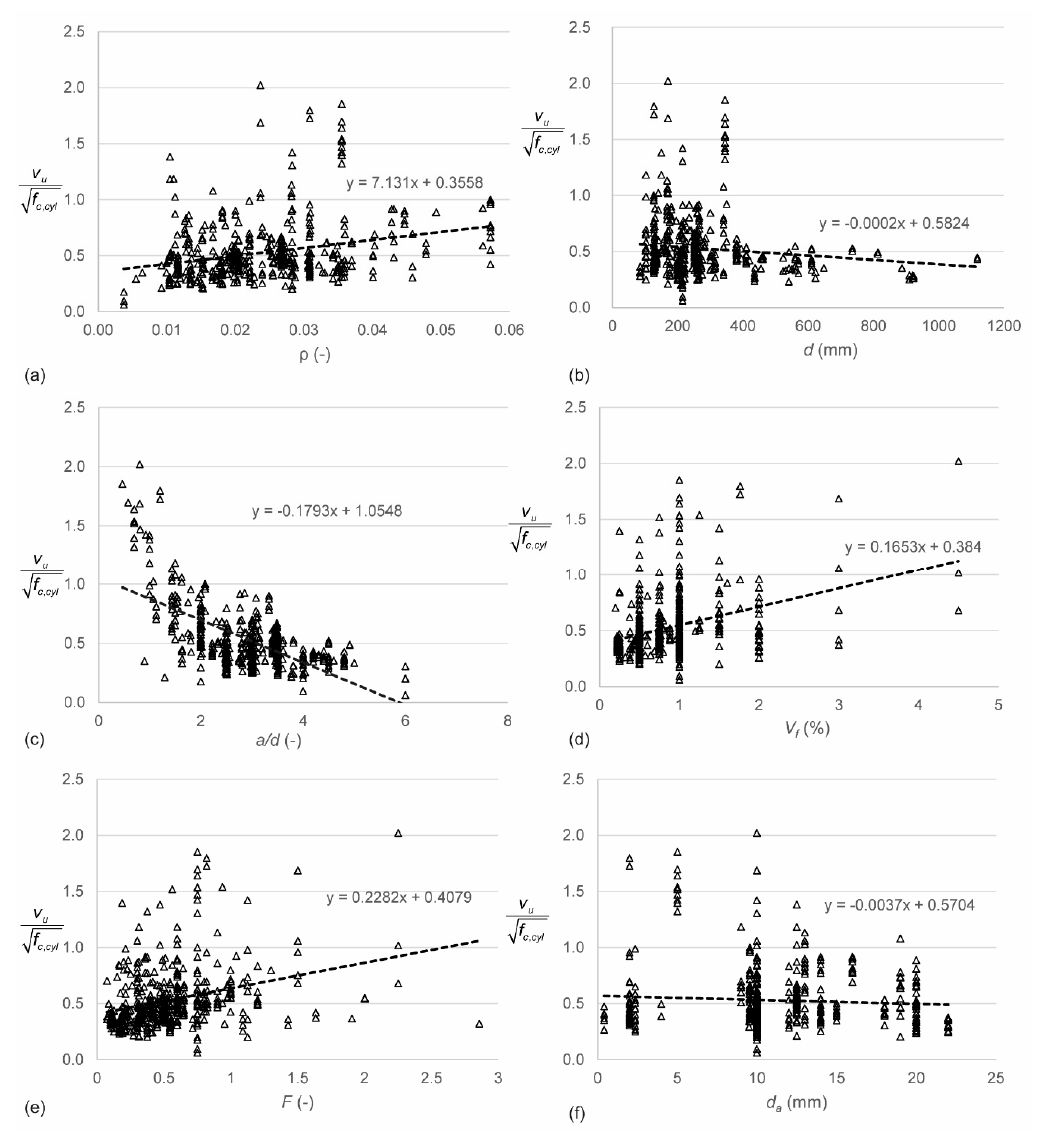
Figure 3. Parameter studies based on normalized shear stresses for all entries in database, influence of ( a ) longitudinal reinforcement ratio ρ ; ( b ) effective depth d ; ( c ) shear span to depth ratio a / d ; ( d ) fiber volume fraction V f ; ( e ) fiber factor F ; and ( f ) maximum aggregate size d a .